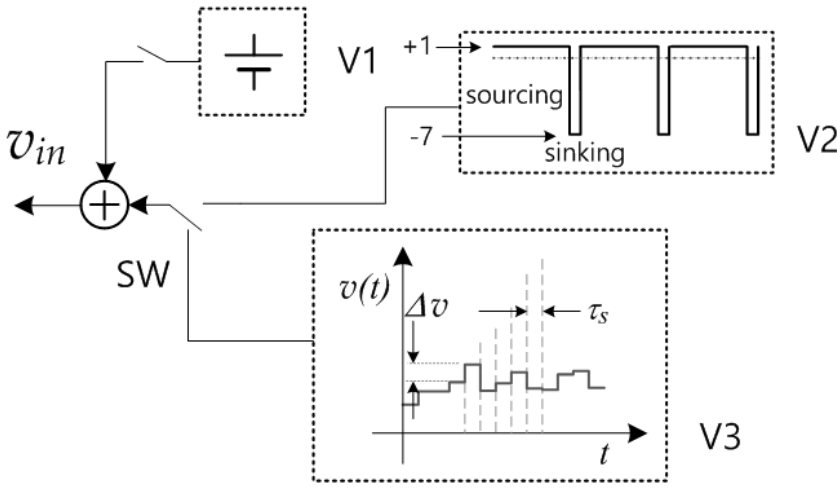
Figure 5. Input into the V-to-I converter. V1 was used to apply DC offset. V2 was the signal waveform used to generate the sawtooth waveform for PZT-TF. The ratio of sourcing to sinking was (+1):( − 7). V3 showed the signal during one sourcing period in V2. The V3 signal was the sourcing waveform of V2 plus the required deformation to keep the spacing between the transmission peaks of etalon constant. A switch, SW, was used to switch between V2 and V3 when the operating mode was changed. The deformation was updated every τ s , which was 57.30 µ s, resulting in 76 updates over every sourcing